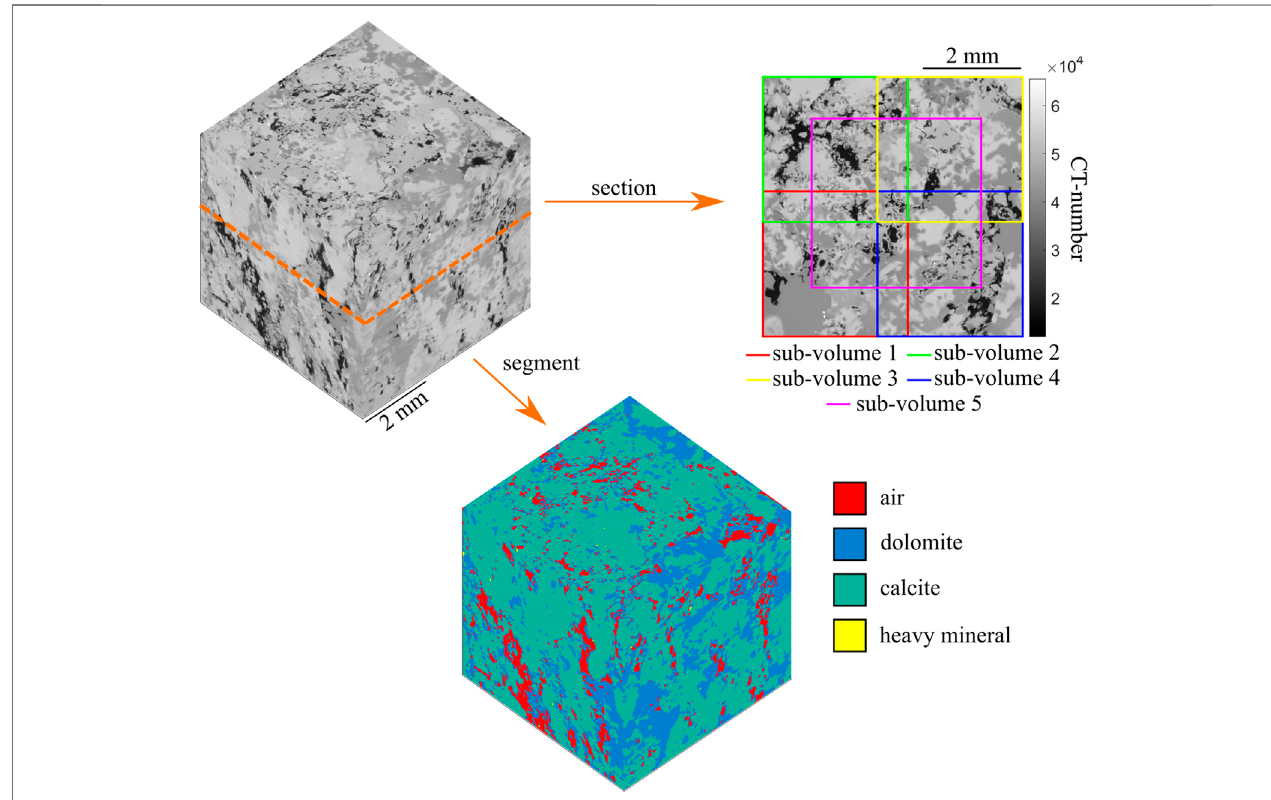
FIGURE3| ACT-volumeofthesamplewiththeinterpretedmineralcompositions.TheCT-volumehasbeensegmentedintofourphases:air,dolomite,calcite,and heavy mineral. The section of the CT-volume shows the location where sub-volumes have been extracted for the numerical simulations.